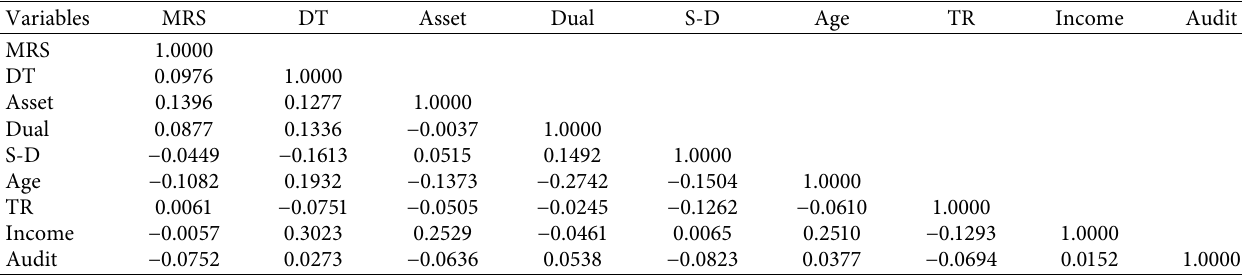
Table 2: Multicollinearity test.